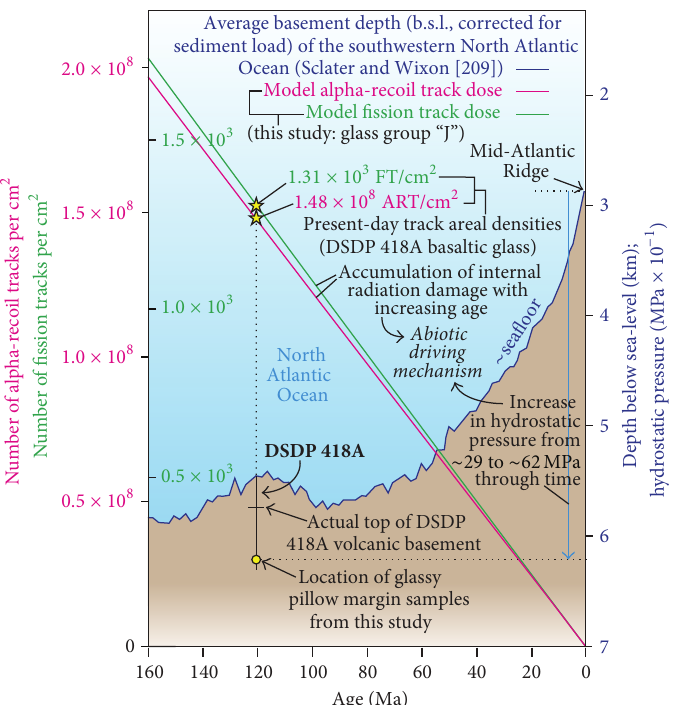
Figure 16: Diagram summarizing the “abiotic driving mechanism” for the formation of complex corrosion microtextures (i.e., microscopic etch-tunnels and granular palagonite) in DSDP 418A basaltic glass: the concomitant increase in hydrostatic pressure and accumulation of radiation damage in basaltic glass with aging of the oceanic crust. The following is depicted in this diagram: (i) the depth-age relationships for volcanic basement in the oceanic crust—depicted as the average depth to basement below sea level (b.s.l.) (corrected for sediment load) for the southwestern North Atlantic Ocean (jagged blue line; from Sclater and Wixon [209]); (ii) the location of DSDP Hole 418A (note that the actual top of volcanic basement in this drill hole is slightly lower than the southwestern North Atlantic average (jagged blue line)); (iii) the inferred hydrostatic pressure in the water column (which can be read at right, along with ocean depth); and (iv) curves (although they are nearly straight lines in this plot) depicting the accumulation (dose) of radiation damage in basaltic glass group “J” (g.g. “J” in Figure 5(b)) through time—that is, the systematic increase (with age) in model fission track and alpha-recoil track areal densities intersecting a hypothetical flat fracture plane through DSDP 418A basaltic glass (calculated using (1) and